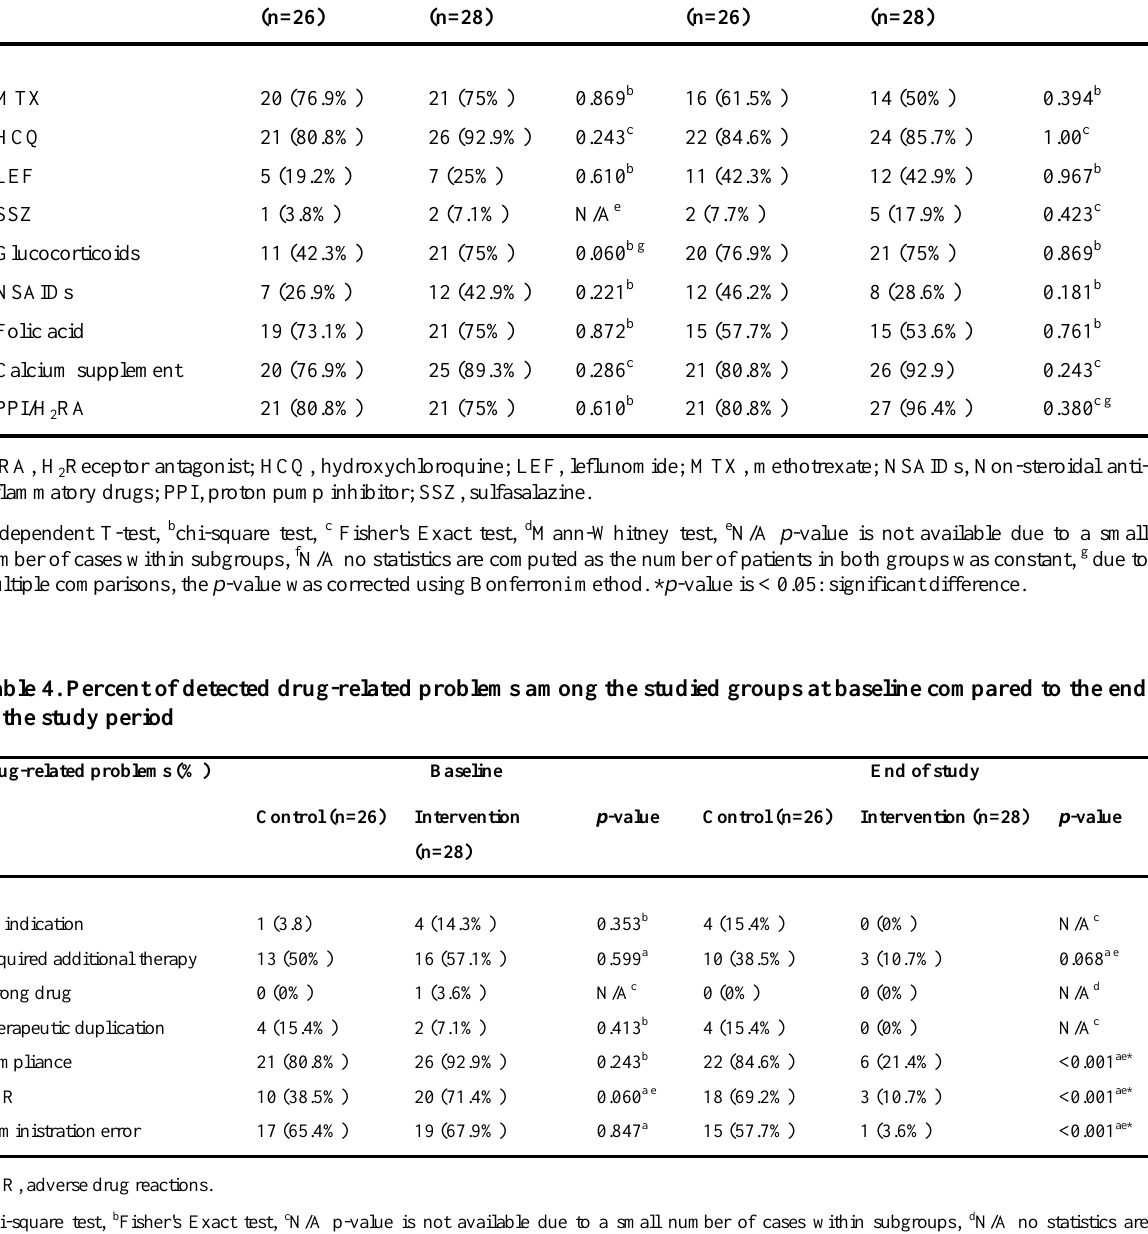
Table 3. Medications prescribed for the study patients at baseline compared to the end of the study Medications